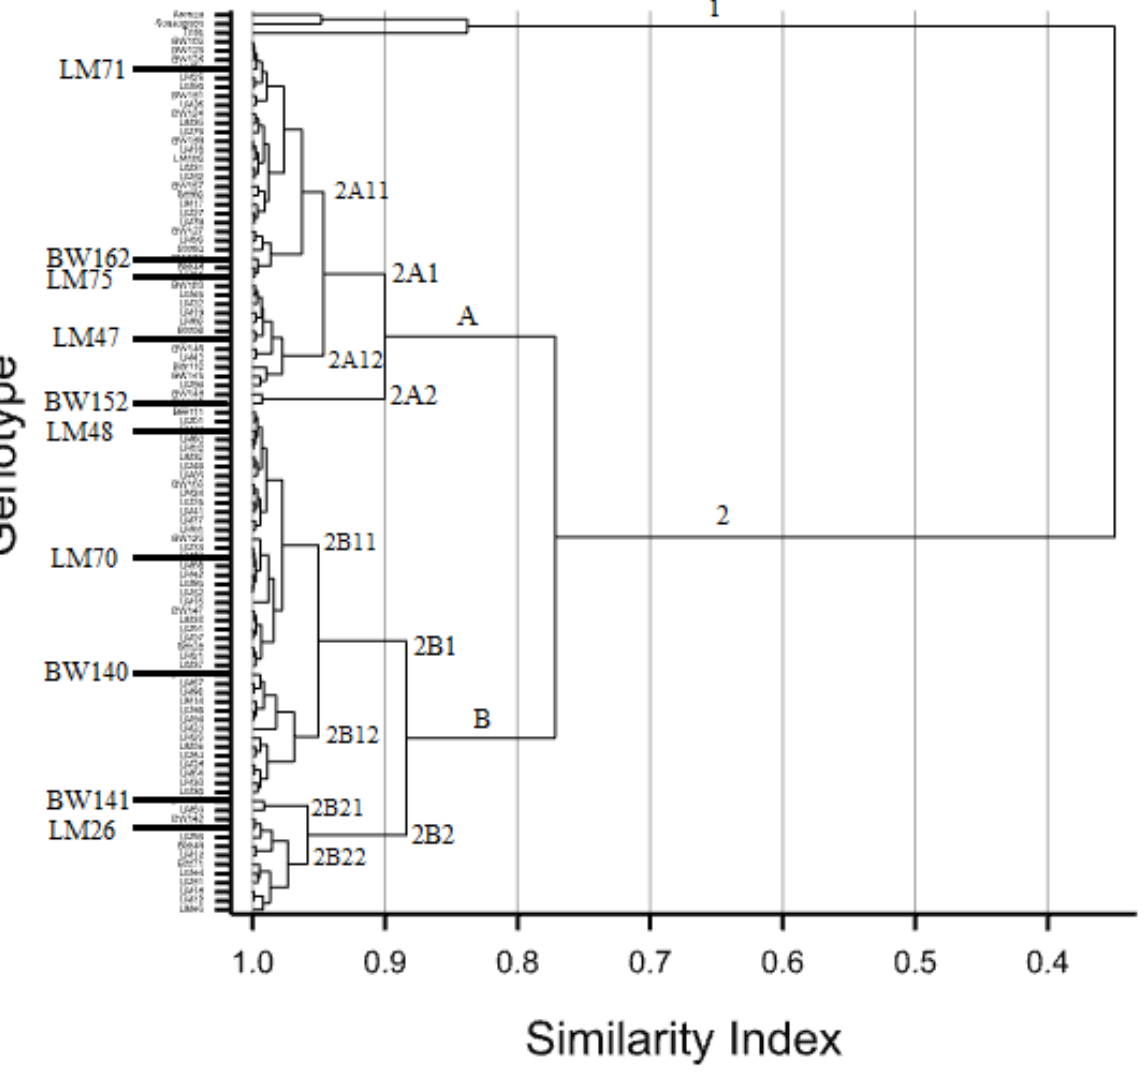
Dendrogram showing clusters according to phenotypic relatedness of Figure 1. Dend r ogram showing clusters according to phenotypic relatedness of 100 genotypes eval- 100 genotypes uated.